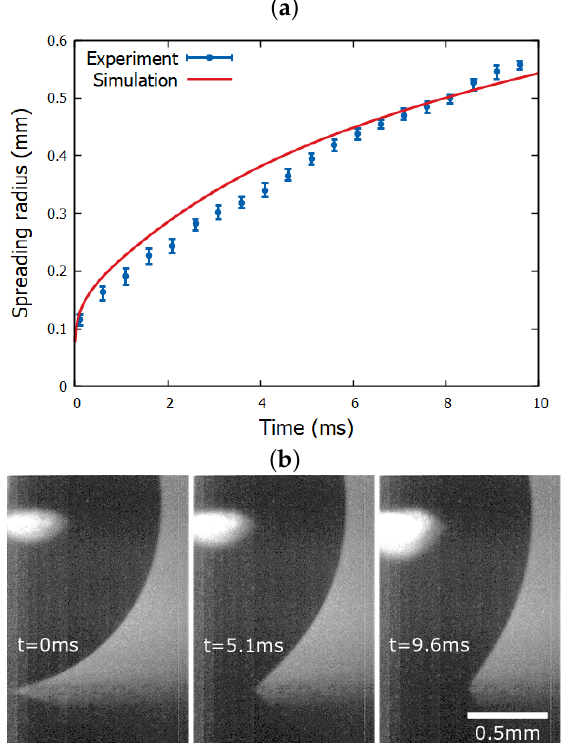
Figure 3. ( a ) Temporal evolution of the contact radius of a glycerin droplet as obtained from experiment and a corresponding simulation for electric potential φ = 100 V ( η = 0.95) on a flat and smooth solid dielectric. ( b ) Snapshots of the spreading droplet at t = 0, 5.1 and 9.6 ms, under the effect of electric field, as captured by a high-speed